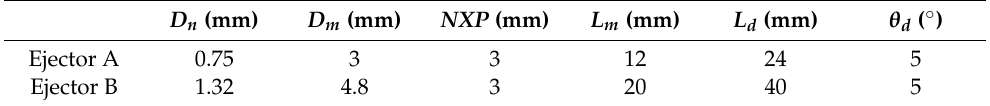
Table 1. Optimized dual-ejector